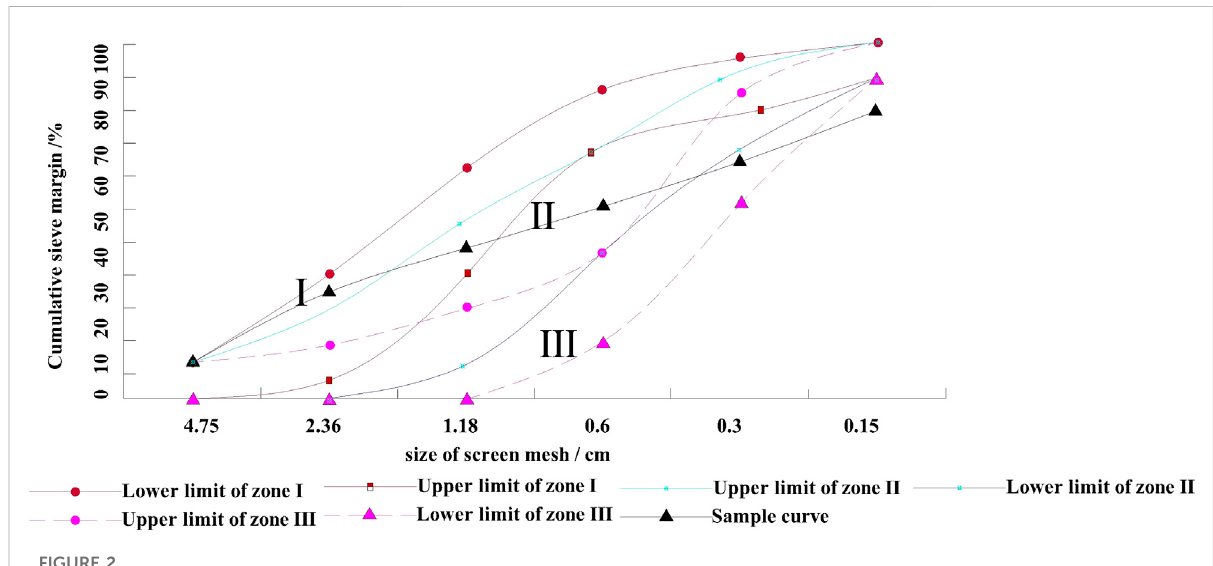
FIGURE 2 Partition diagram of particle curve of the crushed gangue.